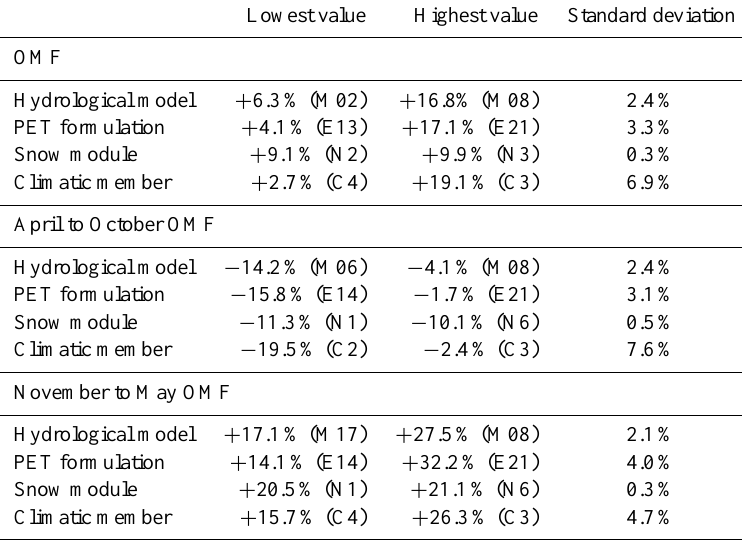
Table 5. Characteristics of the median OMF relative change for different processes and periods. Lowest value Highest value Standard deviation OMF Hydrological model PET formulation Snow module Climatic